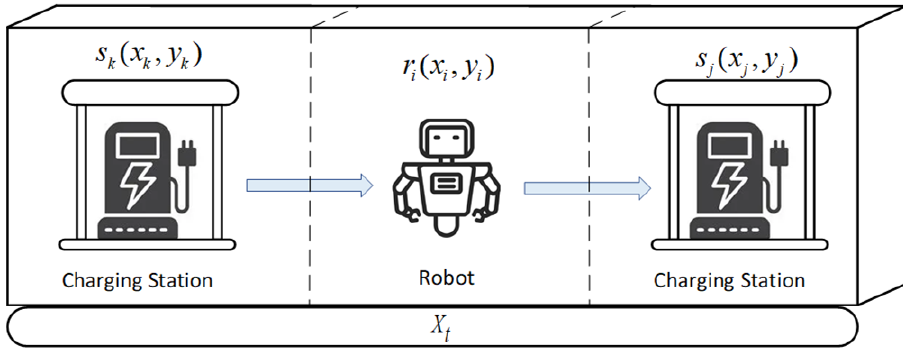
Figure 3. Three nodes task link list of robot-trailer.